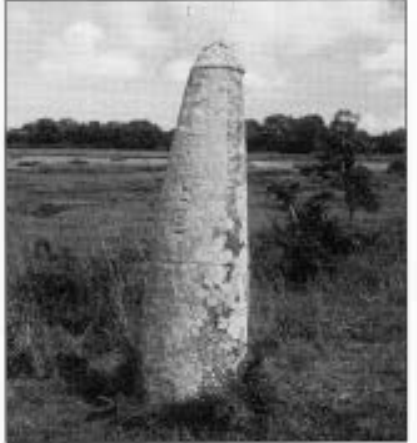
Figure 6 The Prostlon stone from Locoal­ Mendon, in the Morbihan, may have been raised for Prostlon, who was the daughter of Solomon, the ruler of Brittany in the late ninth